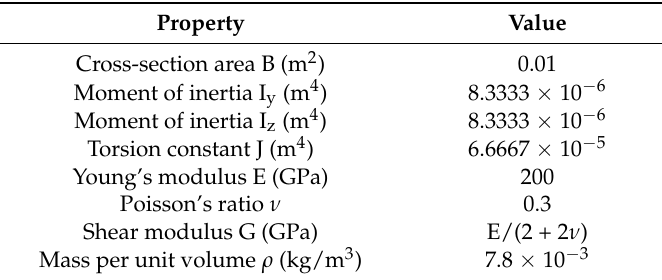
Figure 3. FE model of the spatial frame structure. Table 1. Properties of structural member elements.